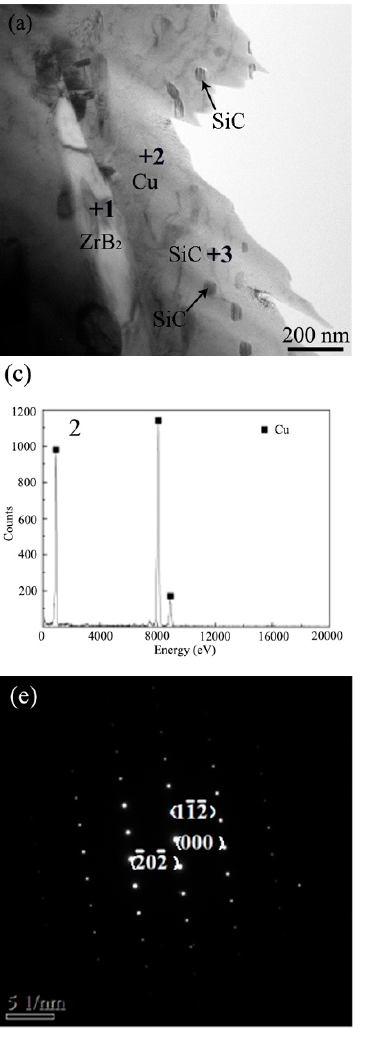
Figure 10. ( a ) TEM images of the composites (20 wt%, 66.67 kJ/cm 2 ). EDS result of ( b ) ZrB 2 , ( c ) Cu and ( d ) SiC. ( e ) Selected area diffraction patterns of SiC.